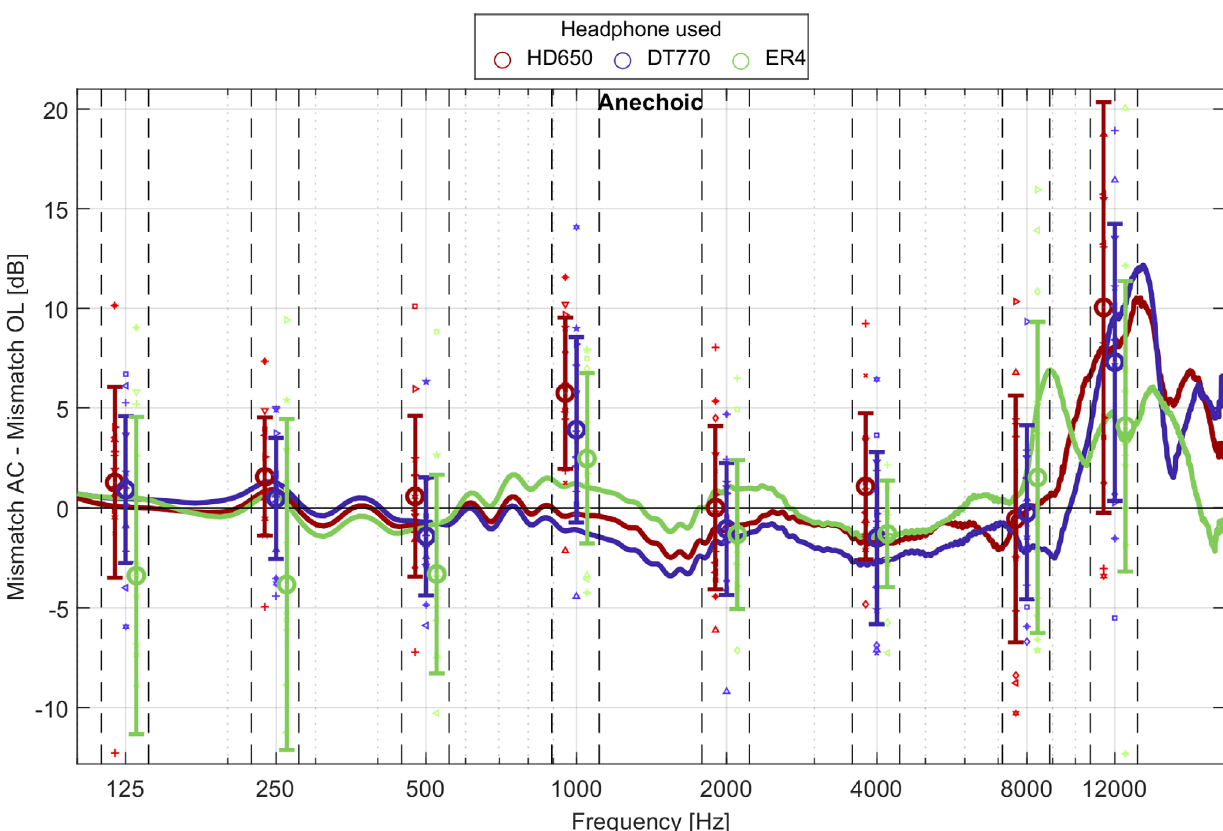
Figure 6. Differences in individual mismatch between anechoic rooms in Aachen and Oldenburg. Each small marker is the difference for one speci fi c participant, bigger markers the mean over all participants. Whisker denote the standard deviation. Colours represent one speci fi c headphone type. Solid lines show the calculated mean deviations in mismatch due to the HpTF and HRTF average deviation across sites. The x -axis indicates the frequency with vertical lines showing the boundaries of the one-third octave bands employed for the stimuli in the listening tests. The red markers for HD650 and the green markers for the ER4 are shifted in frequency for better